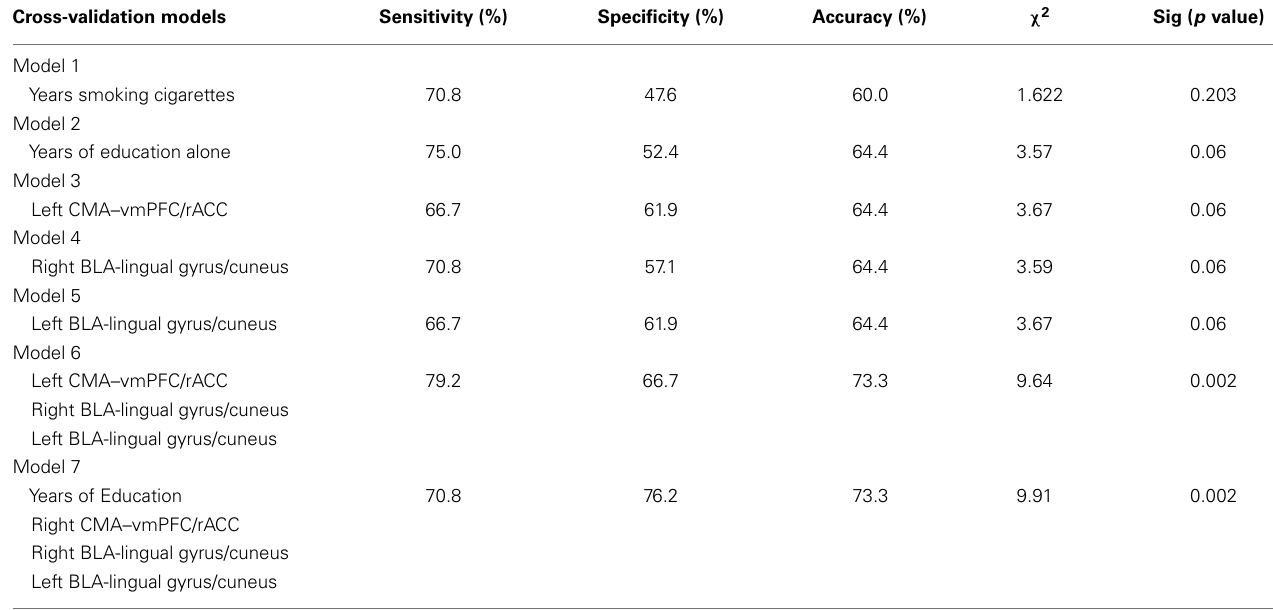
Table 3 | Summary of leave-one-out cross-validation models predicting relapse status at day 30 post-treatment based on rsFC, years smoking cigarettes, and years of